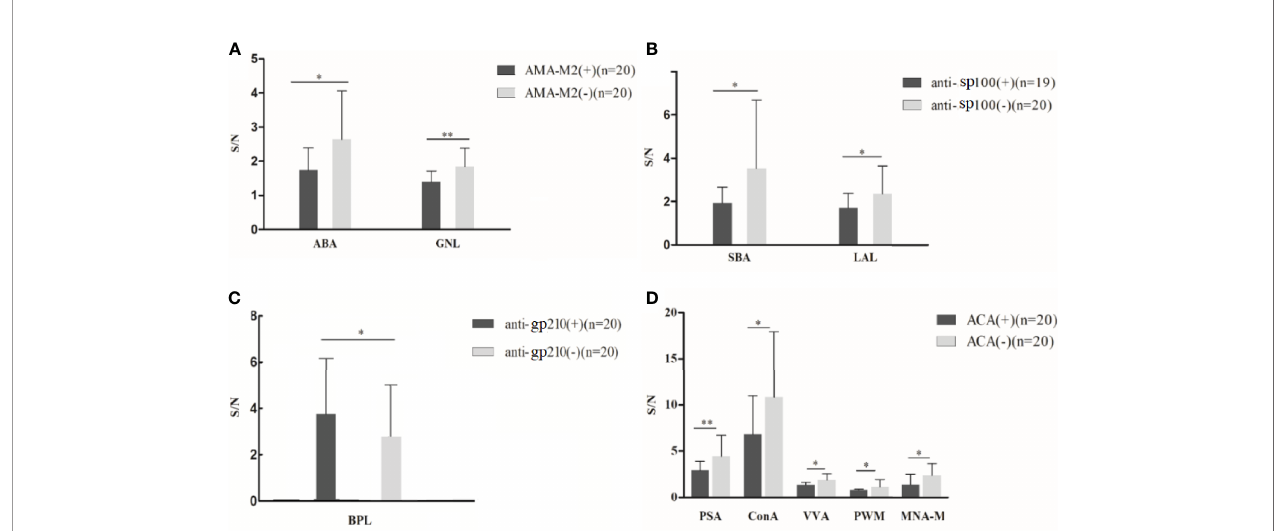
FIGURE 2 | Binding levels of speci fi c lectins between autoantibody-positive and negative groups in PBC patients from lectin microarray. (A) Comparison of serum IgG glycosylation between AMA-M2 positive and negative groups (group A and group B); (B) Comparison of serum IgG glycosylation between sp100 positive and negative groups (group C and group A); (C) Comparison of serum IgG glycosylation between gp210 positive and negative groups (group D and group A); (D) Comparison of serum IgG glycosylation between ACA positive and negative groups (group E and group A). * P < 0.05,** P < 0.01. ABA, Agaricus bisporus lectin; GNL, Galanthus nivalis lectin; SBA, glycine max lectin; LAL, Laburnum anagyroides lectin; BPL, Bauhinia purpurea lectin; PSA, Pisum sativum agglutinin; ConA, concanavalin A lectin; VVA, Vicia villosal lectin; PWM, Phytolacca americana lectin; MNA-M, Morniga M lectin. S/N, the medium intensity of the spot foreground relative to the